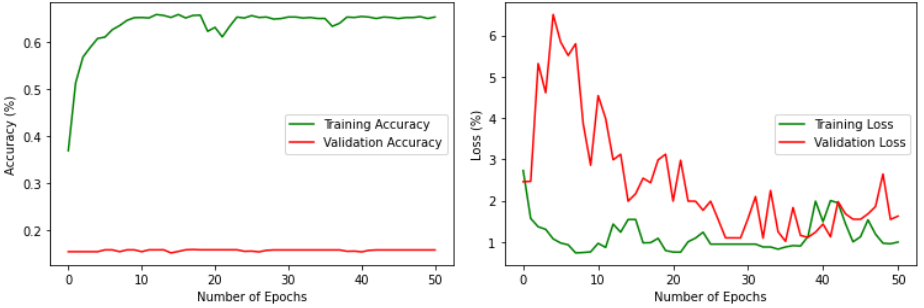
Figure 4. Accuracy and loss, respectively, for the imbalenced data.